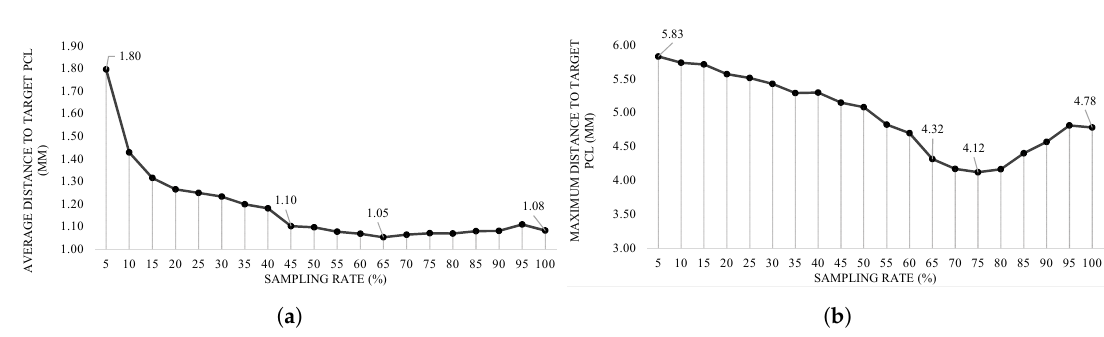
Figure 14. Impact of sampling breast PCL on the average ( a ) and Hausdorff ( b ) with respect to the pair-wise distance.